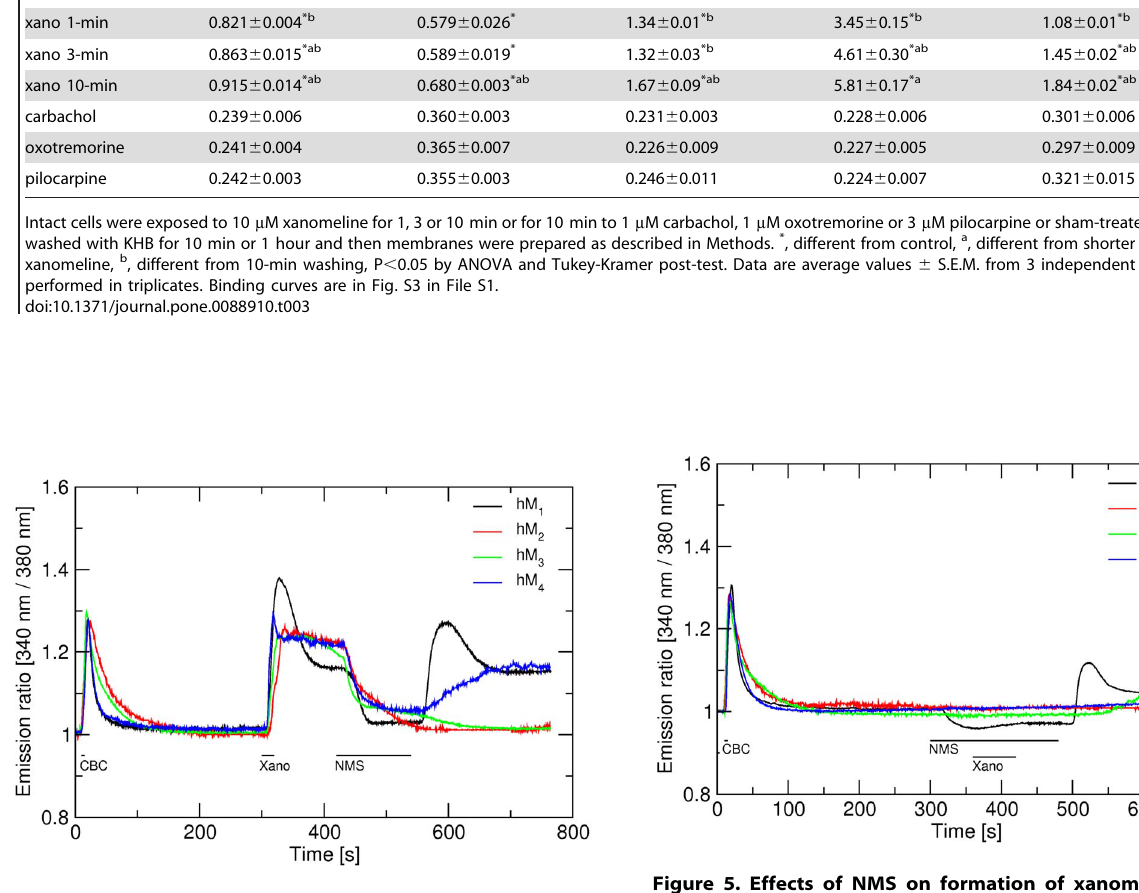
Figure 4. Effects of NMS on delayed elevation of intracellular calcium levels induced by short-term application of xanome- line at hM 1 through hM 4 receptors. Changes in the concentration of intracellular calcium (ordinate) are expressed as changes in fluorescence intensity (340 nm/380 nm) ratio normalized to basal calcium level. First (control) stimulation: 300 nM carbachol (CBC) for